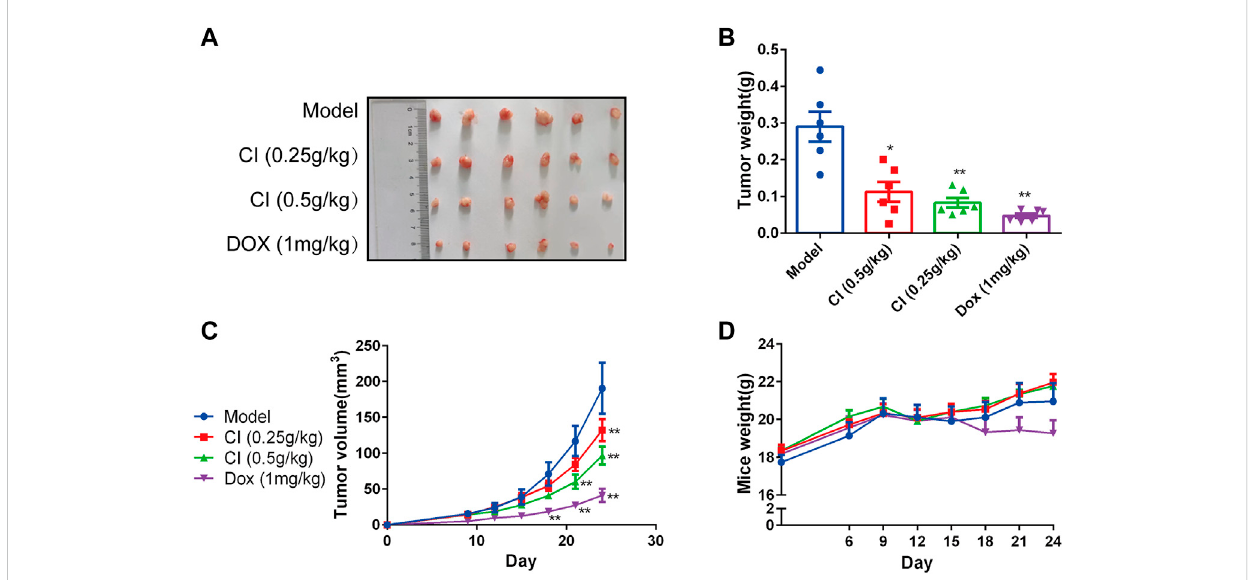
CI inhibits growth and development in ectopic subcutaneous tumor model of U2OS. (A) Tumor tissues after sacri fi ce. (B) Tumor weight after CI treatment or DOX. Mean ± SEM. n = 6. * p < 0.05, ** p < 0.01 vs . model group (one-way ANOVA). (C) Tumor volume growth curve after CI treatment